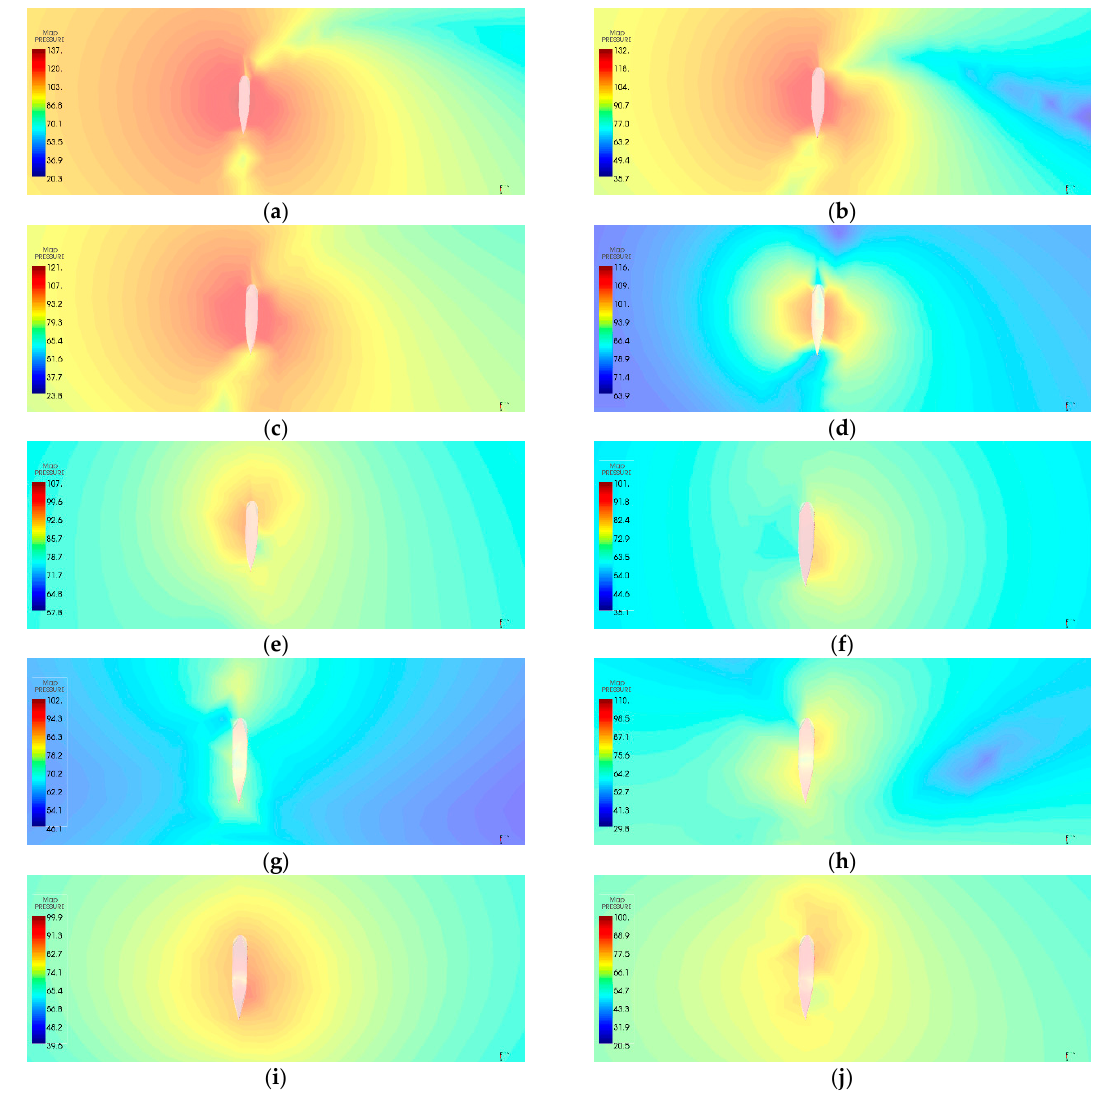
Figure 14. Contour of sound pressure of the sail hull: ( a ) f = 10 Hz; ( b ) f = 50 Hz; ( c ) f = 100 Hz; ( d ) f = 150 Hz; ( e ) f = 200 Hz; ( f ) f = 600 Hz; ( g ) f = 800 Hz; ( h ) f = 1200 Hz; ( i ) f = 1800 Hz; and ( j ) f = 2000 Hz.